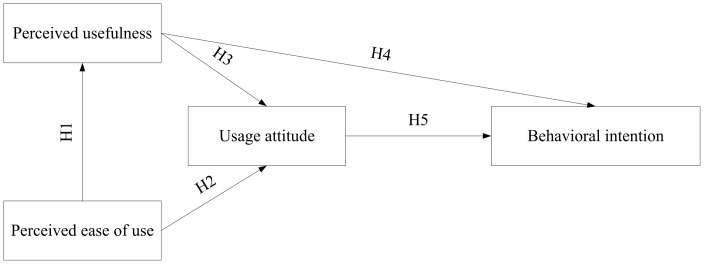
The research model.